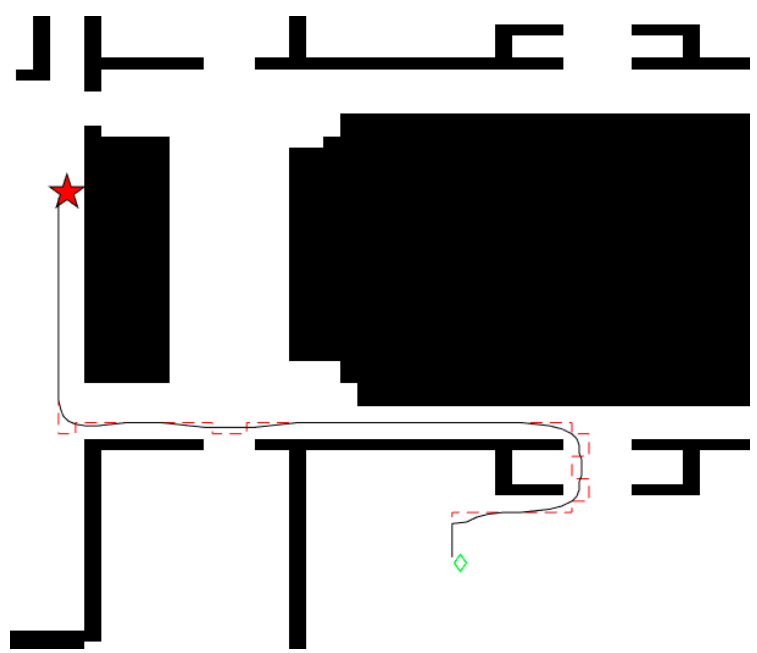
Figure 5. A case of a smoothed path by sliding window: before smoothing (red dotted) versus after smoothing (dark curve).